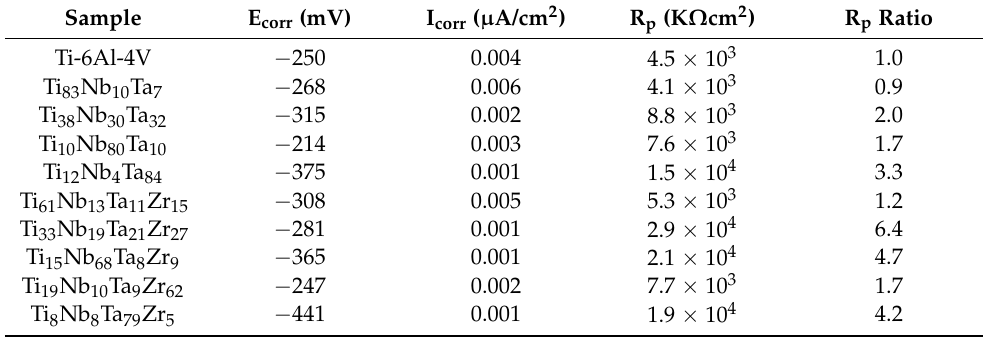
Table 3. Corrosion characteristics of the Ti-6Al-4V substrate and TiNbTa(Zr) films.